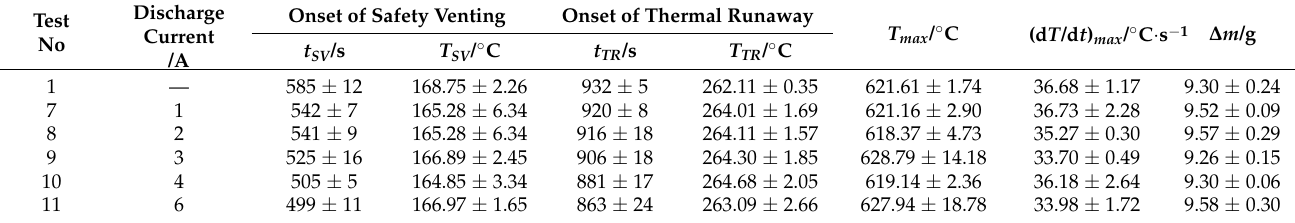
Figure 8. Typical temperature variation of the battery at different discharge currents in Group ⅲ . Table 6. Key parameters of the thermal runaway at different discharge currents in Group ⅲ .